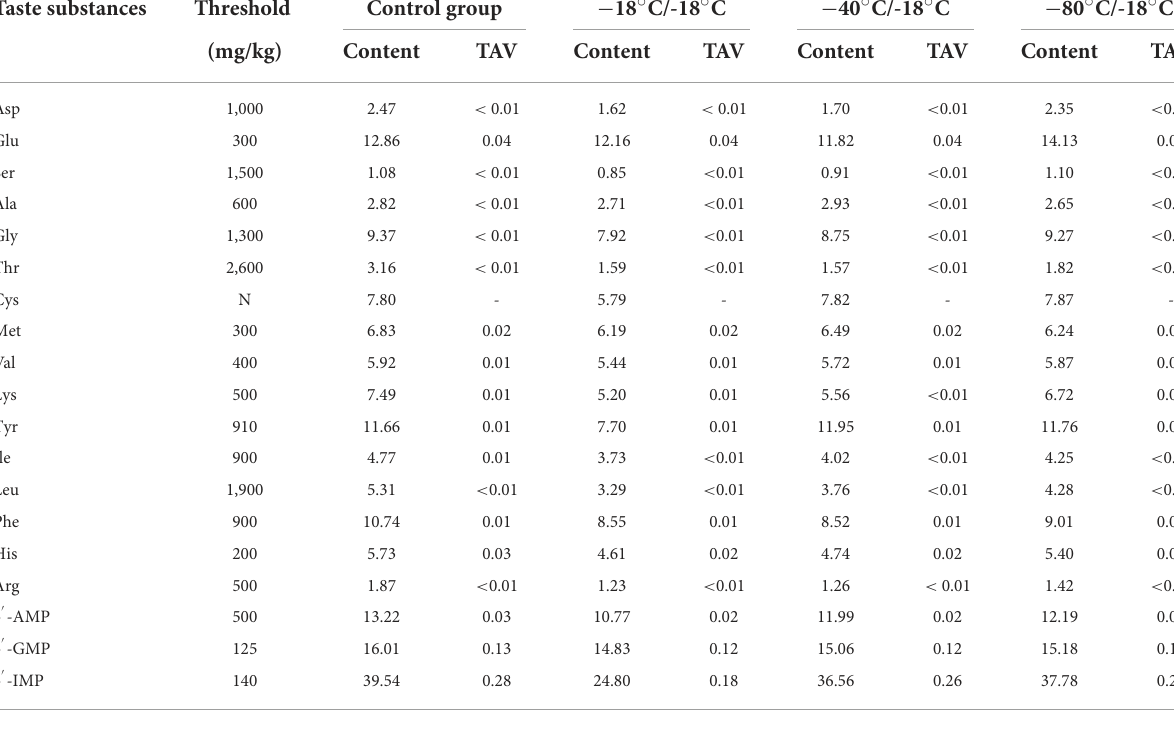
TABLE 6 TAVs of HGM with different freezing rates.